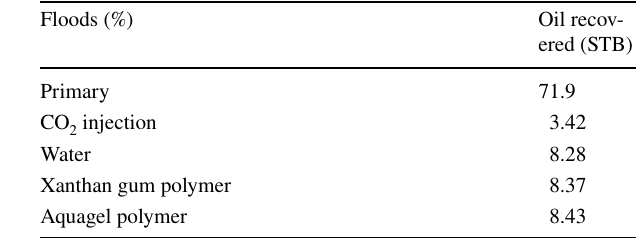
Table 3 Flood optimization data for polymer flooding Parameter